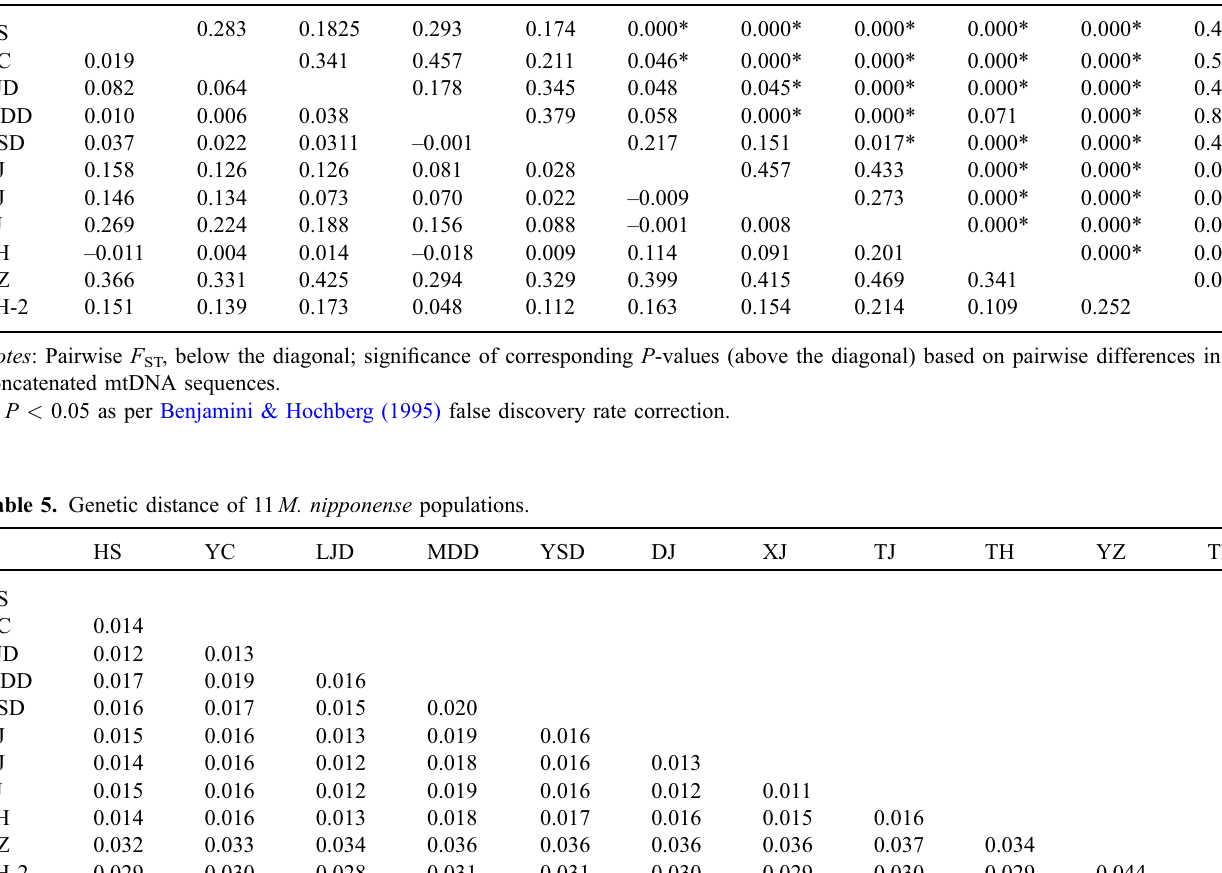
Table 4. Pairwise F ST values of 11 M. nipponense populations. HS YC